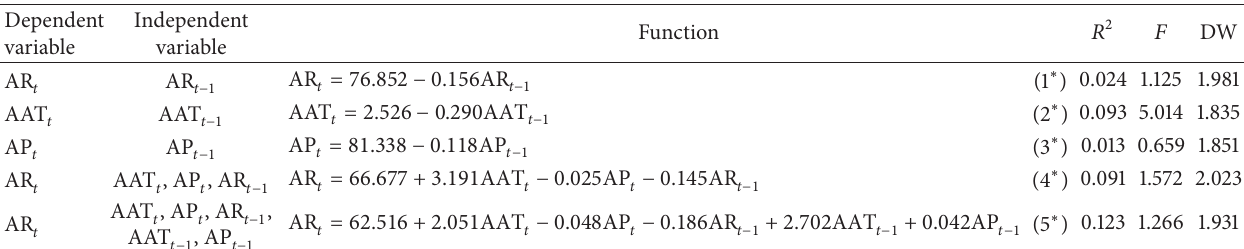
Table 1: Statistical check for variable’s autocorrelation.